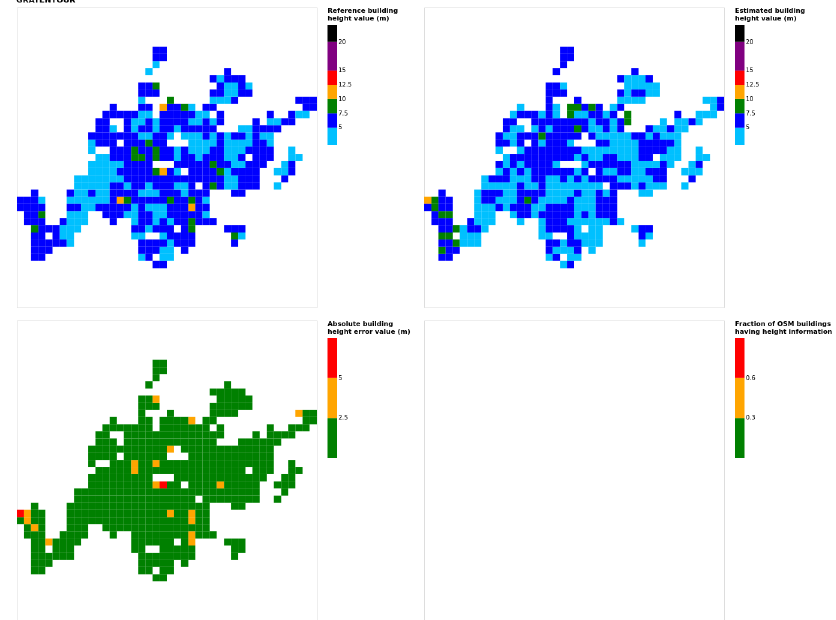
Figure B8. Results for the commune at grid cell (upper left panel) reference building height, (upper right panel) estimated building height, (lower left panel) absolute building height error, and (lower right panel) fraction of OSM buildings that have height information. For all panels except the lower right, only cells that have buildings – with at least 90% of their buildings having no height value in OSM – are